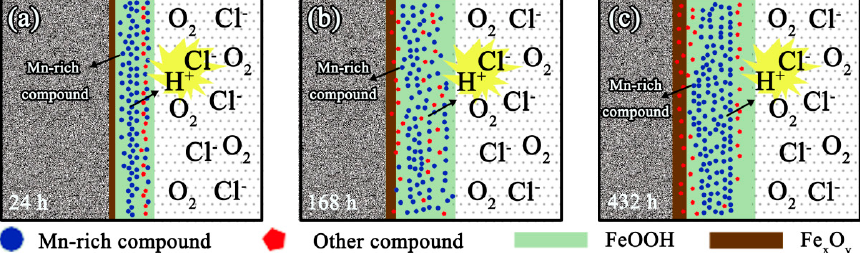
Figure 8. Conceptual model of the corrosion process of the tested medium-Mn steel: ( a ) 24 h; ( b ) 168 h; and ( c ) 432 h.